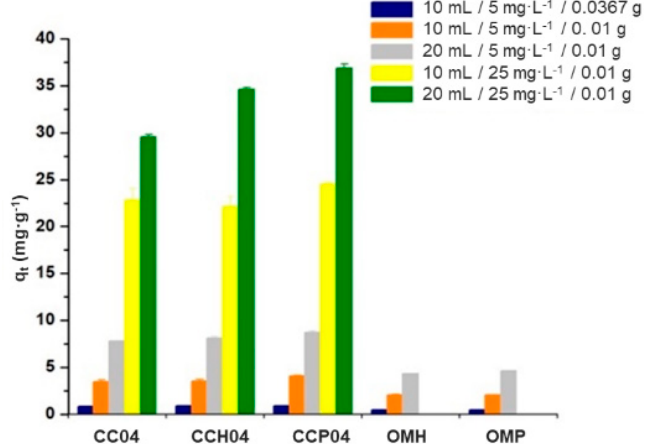
Figure 13. Adsorption experiments varying the mass–volume ratio and the initial concentration of atrazine in the prepared solutions.